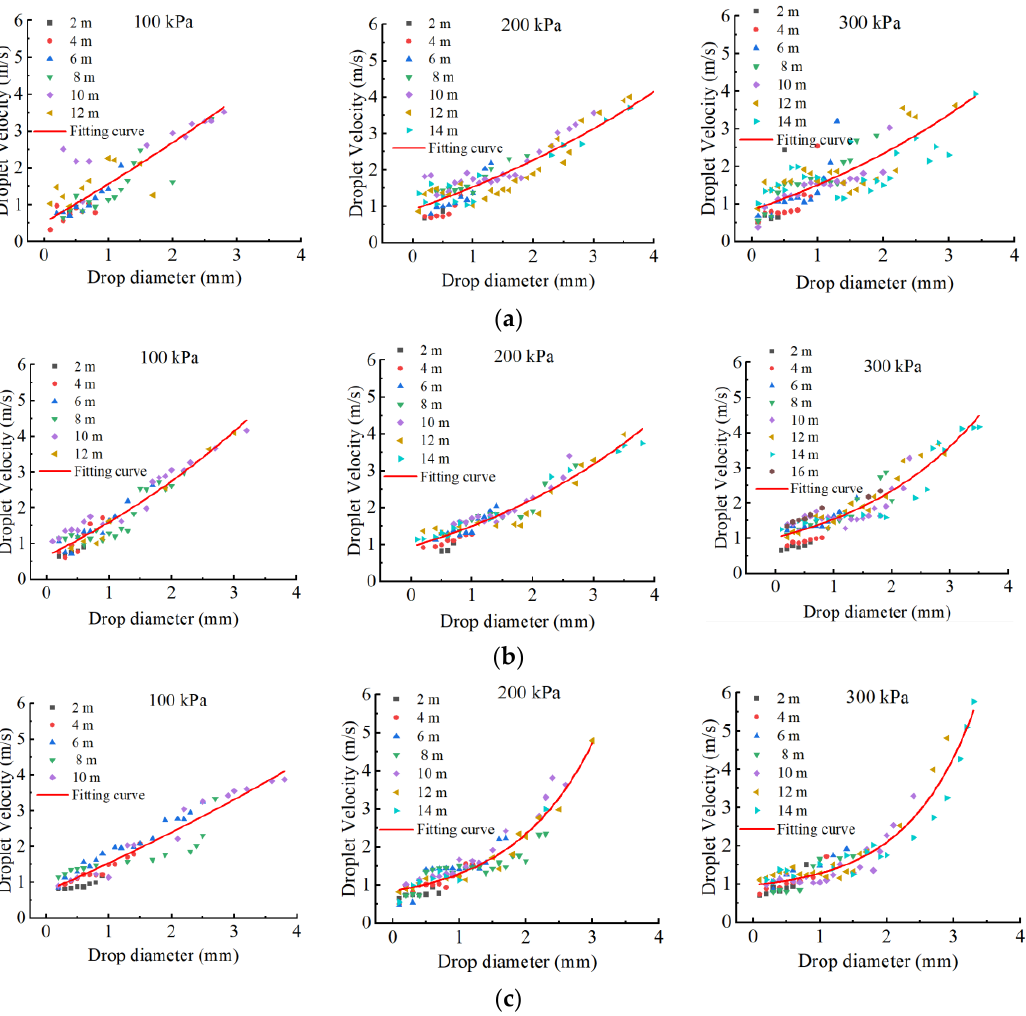
Figure 7. Relationship between droplet size and velocity for different nozzles. ( a ) Circular orifice ( b ) square orifice, and ( c ) triangular orifice. ( b ) square orifice, and ( c ) triangular orifice. Table 4. Exponential relationships between the droplet diameter and velocity for different nozzles. Orifice Shape Pressure